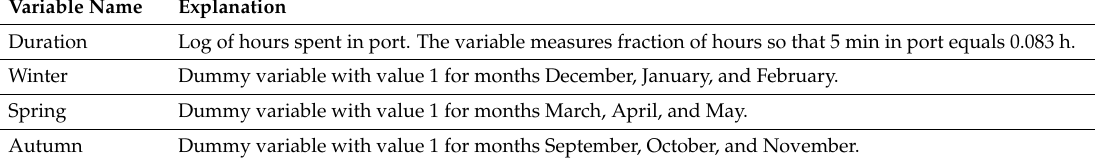
Table 6. Definitions of independent variables in regression model for Finnmarken’s fuel consumption in